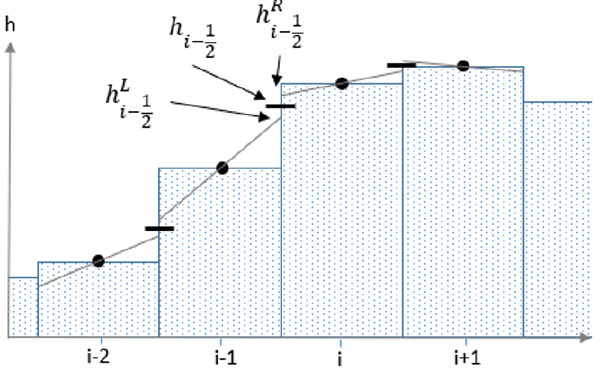
Figure C2. Piecewise linear reconstruction is used by the MUSCL scheme to estimate values of flow heights, velocities and terrain at cell